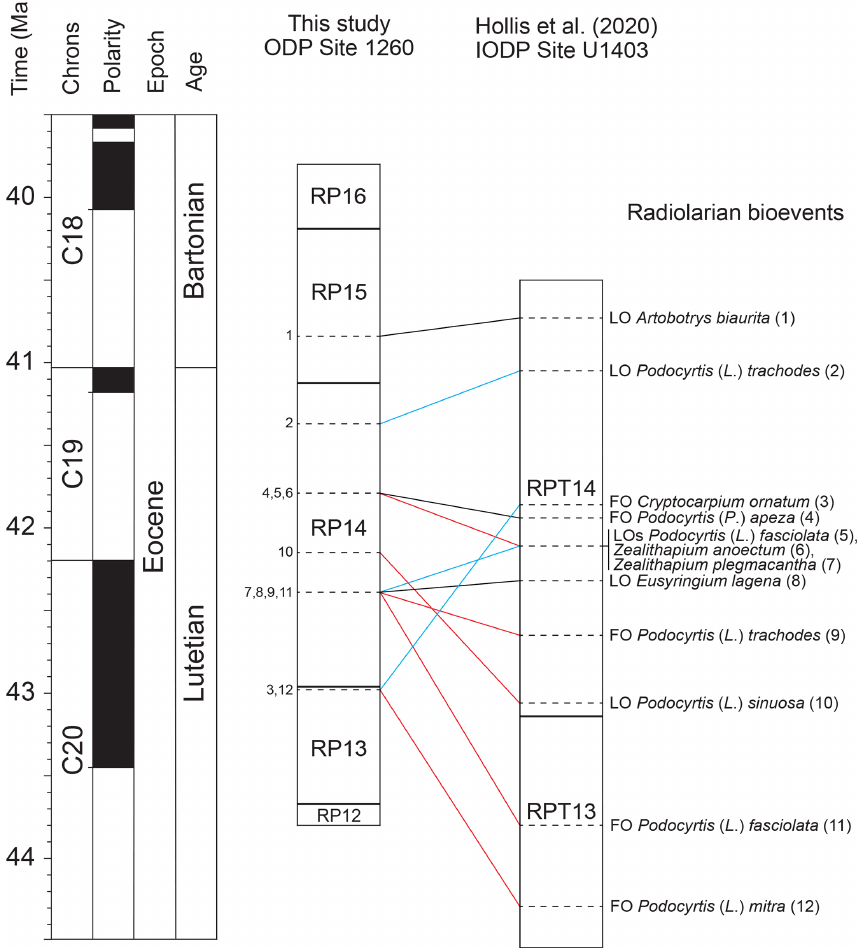
Figure 4. Correlation of radiolarian bioevents between ODP Site 1260 (this study) and IODP Site U1403 (Hollis et al., 2020). Black lines represent nearly synchronous bioevents, blue lines represent diachronous bioevents which first occur at ODP Site 1260, and red lines represent diachronous bioevents which first occur at IODP Site U1403. The geomagnetic timescale is after Speijer et al.